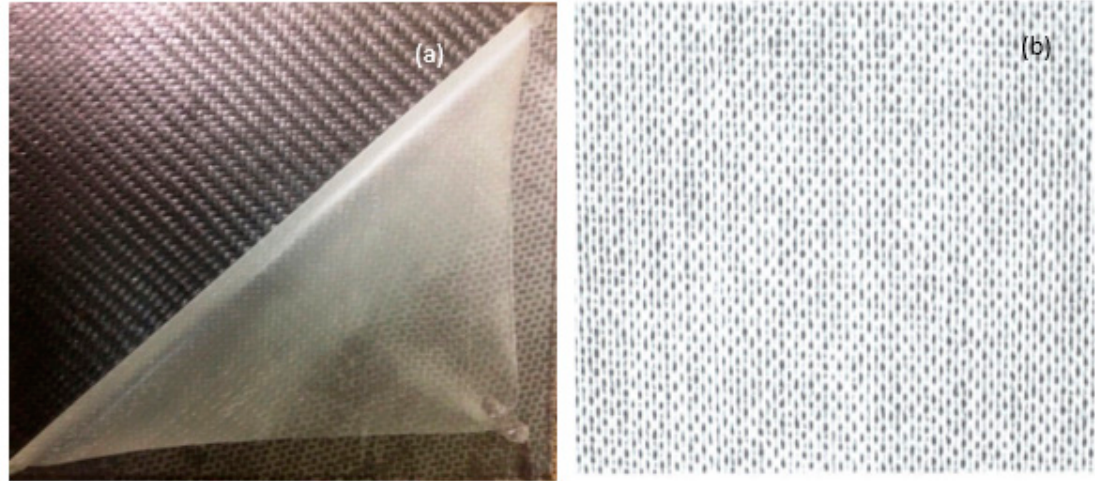
Figure 2. ( a ) Woven carbon fiber/epoxy prepreg before curing. ( b ) Polyester synthetic surface veil.